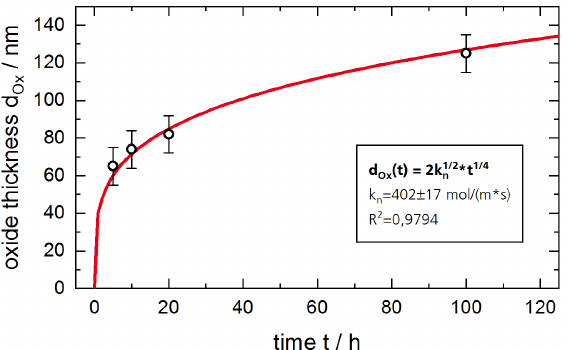
Figure 4. XPS depth profiles after oxidation for 100 h at 700 ◦ C of ( a ) Ti 2 AlN coating, and ( b ) uncoated ferritic steel substrate.